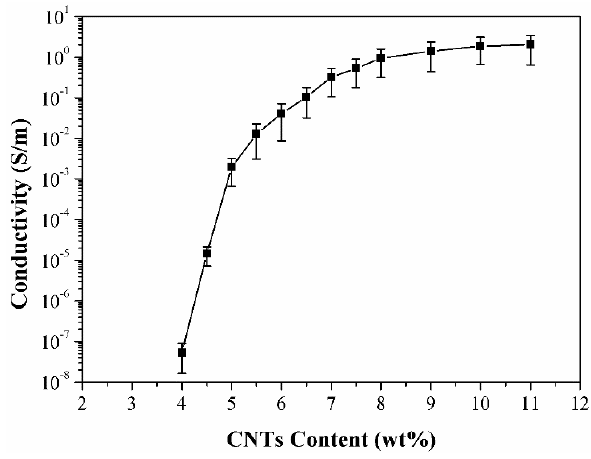
Figure 4. Composite electrical conductivity as a function of MWCNTs content.